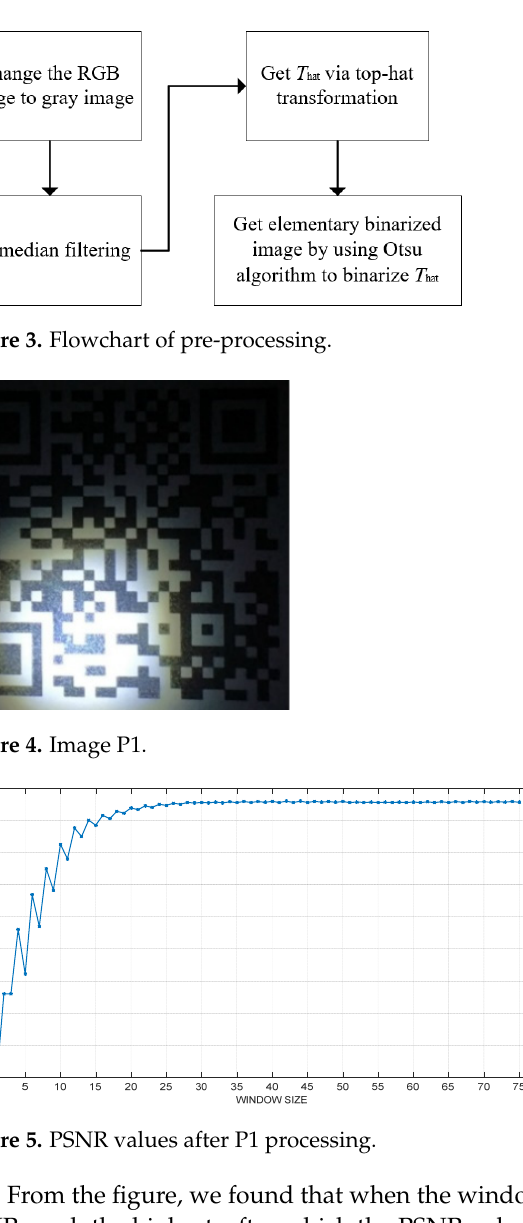
Figure 5. PSNR values after P1 processing.